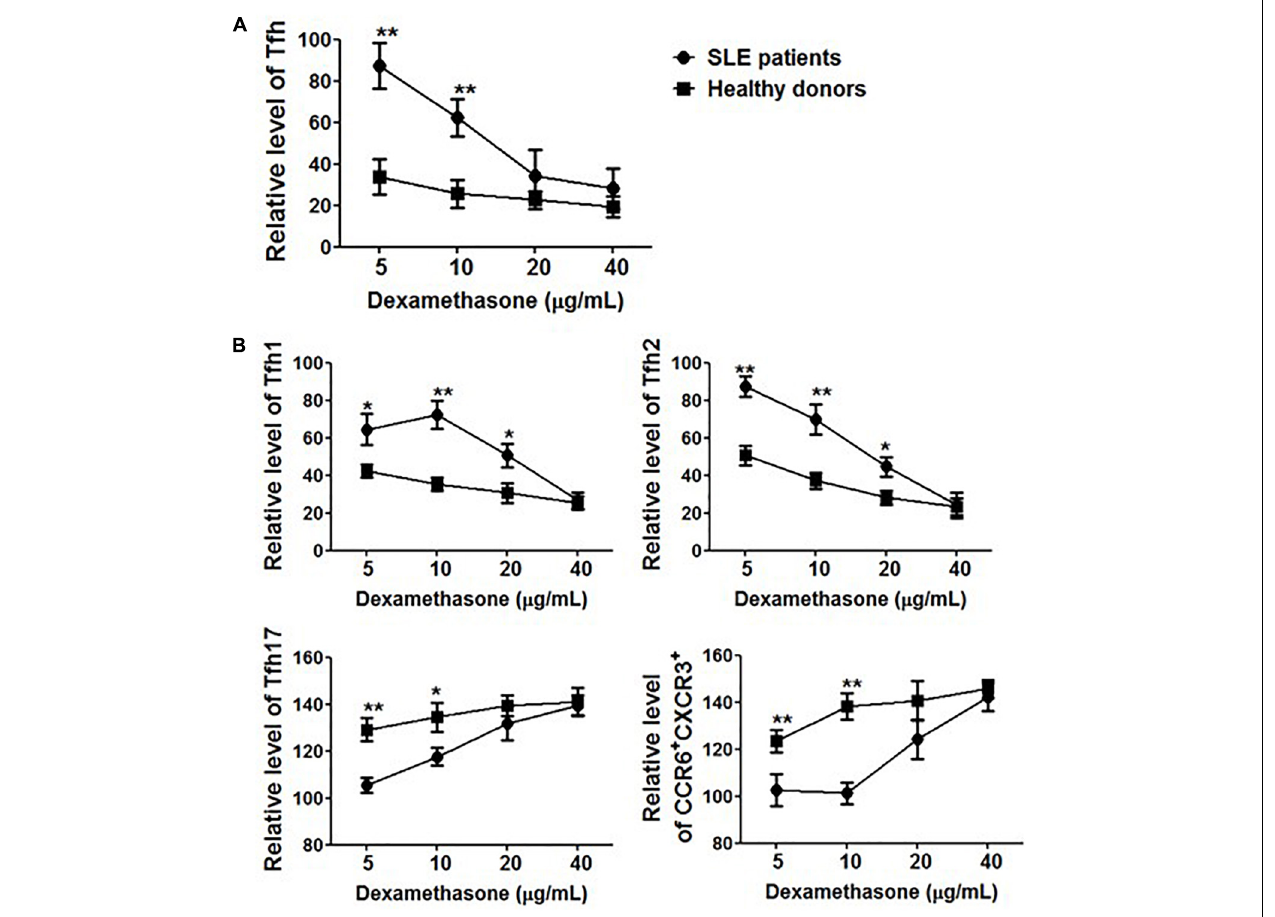
FIGURE 5 | The effect of methylprednisolone on Tfh cells. (A) The relative frequencies of Tfh cells from both SLE patients and healthy controls were measured 24 h after treatments with methylprednisolone at different dosages (5 µ g/ml, 10 µ g/ml, 20 µ g/ml, and 40 µ g/ml). (B) The relative frequencies of Tfh subsets from both SLE patients and healthy controls were measured 24 h after treatments with different dosages of methylprednisolone (5 µ g/ml, 10 µ g/ml, 20 µ g/ml, and 40 µ g/ml). All results are presented as mean ± standard error of the mean (SEM). * p < 0.05, ** p <